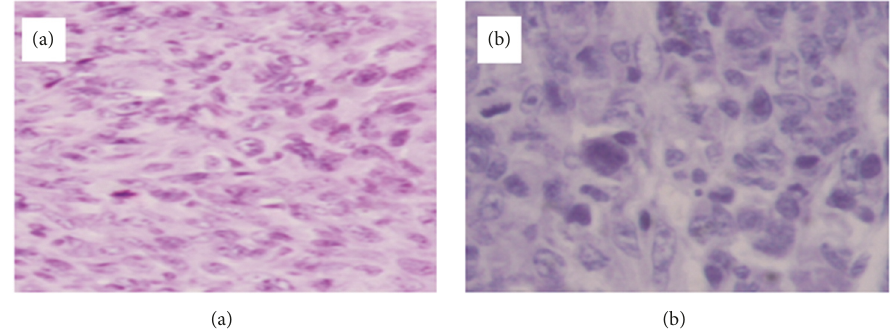
Figure 15: Microscopic finding of squamous cell carcinoma (1x1 cm) occurring on the right upper thigh after inoculation of SCC-7 in control group (a) and 10mA × 600sec group (b). (a) There are mainly well-differentiated spindle cells with whirled solid pattern and some mitotic figures (H & E, x200). (b) Tissue section taken 6 hours after treatment in experimental group received 1 coulomb. There are fully differentiated spindle cells without difference comparing control (H & E, x400).